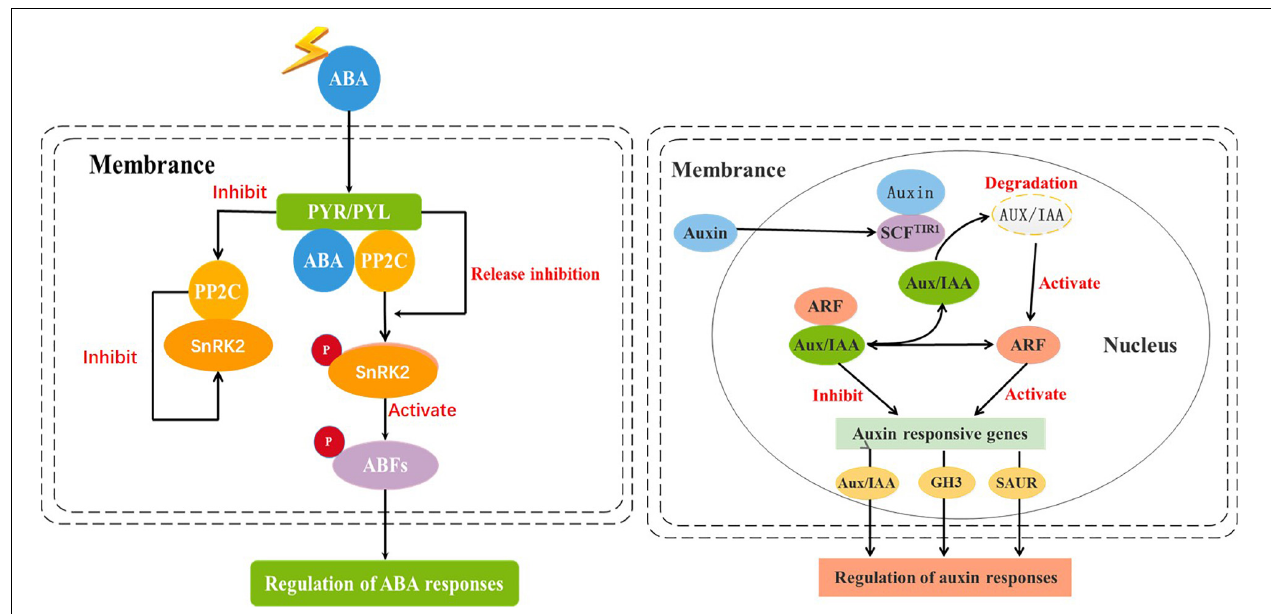
FIGURE 6 | The key genes in abscisic acid ABA (Left) and auxin IAA (Right) synthesis pathway. The DEGs (Pyrabactin resistance/pyr1-like (PYR/PYL), Serine/threonine protein phosphatase ( PP2C ), Sucrose non-fermenting 1-related protein kinase 2 ( SnRK2 ), ABA responsive element binding factors ( ABFs )) in invasive plant and hybrid under Cd stress were located in the ABA synthesis pathway, and the DEGs (Auxin receptor ( TIR1 ), Auxin/indole-3-acetic acid ( Aux/IAA ), Auxin response factor ( ARF ), Gretchen hagen 3 ( GH3 ), Small auxin-up RNA ( SAUR )) were located in the IAA synthesis